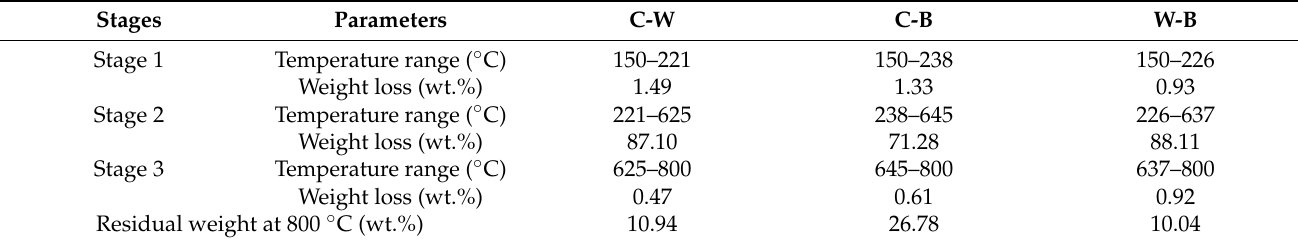
Table 3. The degradation parameters of the binary